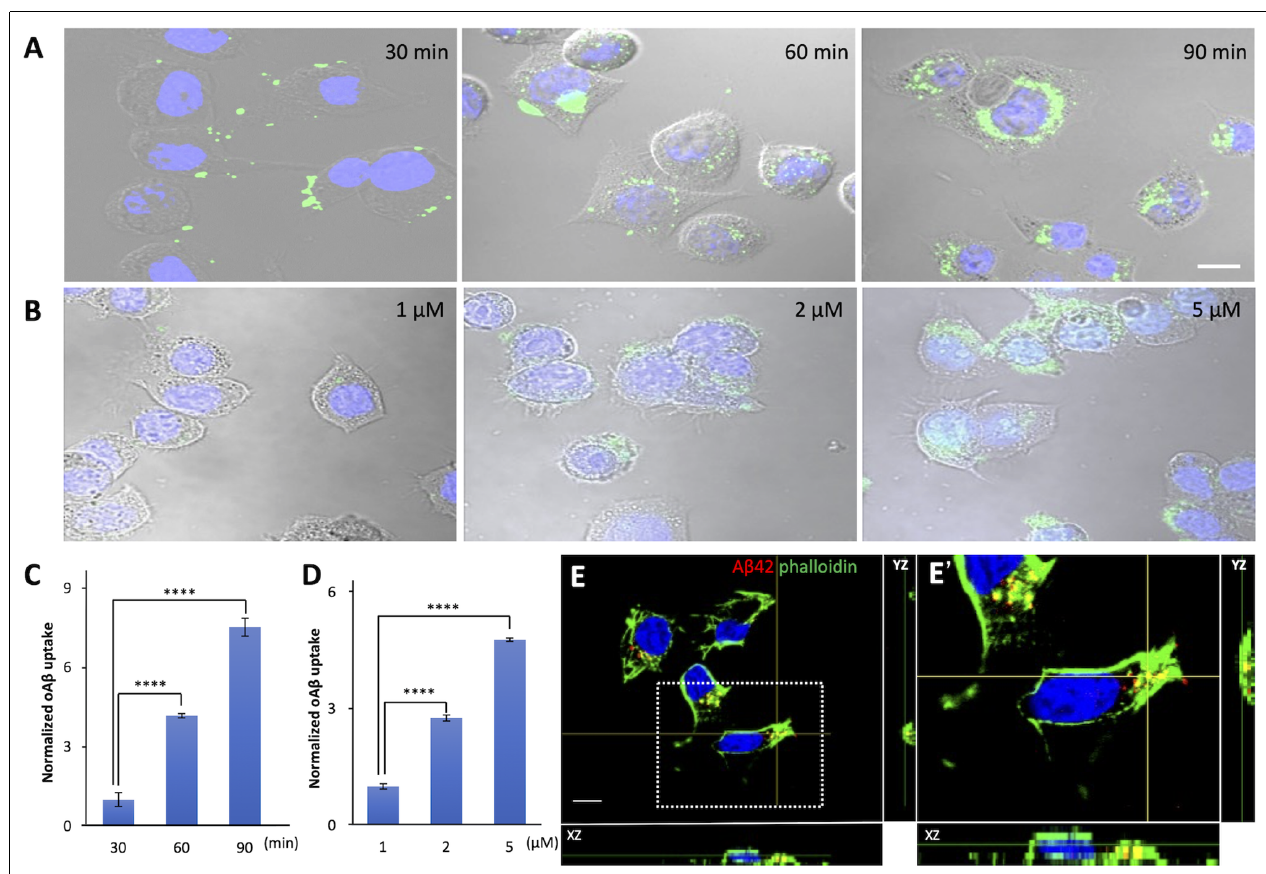
FIGURE 1 | The time and dose dependence of cellular uptake of amyloid beta in neuroblastoma cells. (A) Neuro2A cells were allowed to internalize 5 µ M FITC-labeled oA β 42 for 30, 60, and 90 min, followed by washing and fixation. Nuclei were stained with DAPI (blue). (B) Neuro2A cells were treated with 1, 2, and 5 µ M oA β 42 for 90 min and nuclei were stained with DAPI. All experiments were repeated three times. Quantification of the fluorescence intensity shows (C) a time-dependent increase in intracellular oA β 42 and (D) a dose-dependent increase in intracellular oA β 42. All experiments were repeated three times. Data are presented as mean ± SEM, and data are presented as mean fluorescence normalized to 30 min or 1 µ M. Error bars indicate standard error ( n = 3). Significance was established using ANOVA followed by the Dunnett–Square test. Scale bar = 10 µ m. (E) The two orthogonal views (XZ and YZ) on confocal microscopy showed that oA β 42 labeled with TMR was surrounded by actin (arrows) labeled with phalloidin (green). The nuclei were visualized with DAPI (blue). An enlarged view of the boxed region is shown in (E’) . Scale bar = 10 µ m. ∗∗∗∗ p <